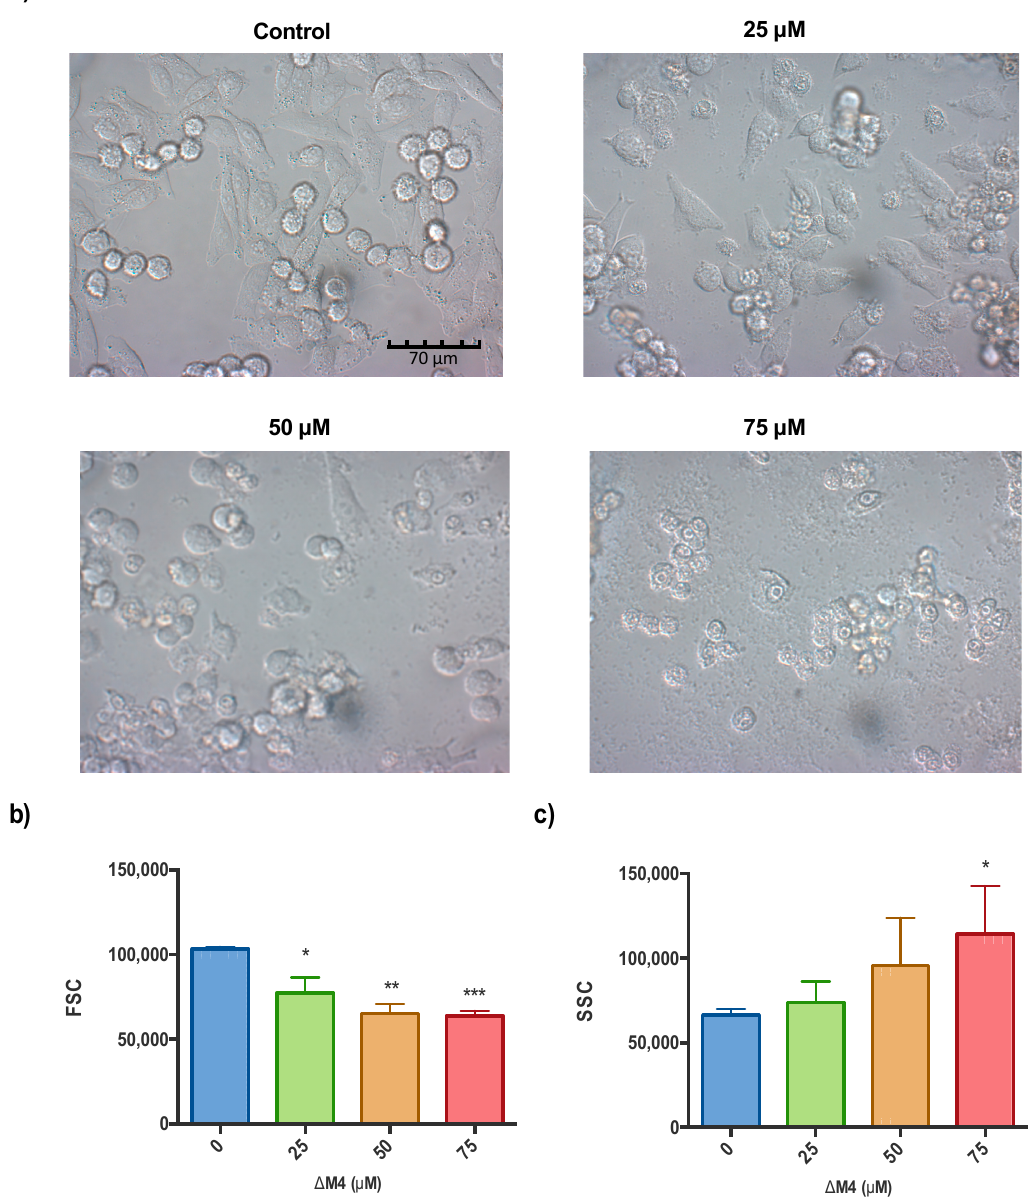
Figure 3. Morphological characterization of A375 cells after Δ M4 treatment. Cells were treated with different concentrations of Δ M4 for 24 h. ( a ) Direct observation by differential interference contrast (DIC) microscopy; ( b ) Measurement of the cell size represented as the mean of the intensity of the signal detected by the forward scatter (FSC) parameter by flow cytometry; ( c ) Measurement of cell granularity represented as the mean of the intensity of the signal detected by the side scatter (SSC) parameter by flow cytometry. Data are expressed as the mean ± SEM of three independent experiments. One-way ANOVA revealed the difference with respect to non-treated cells, where * p ≤ 0.05, ** p ≤ 0.01, and *** p ≤ 0.001.